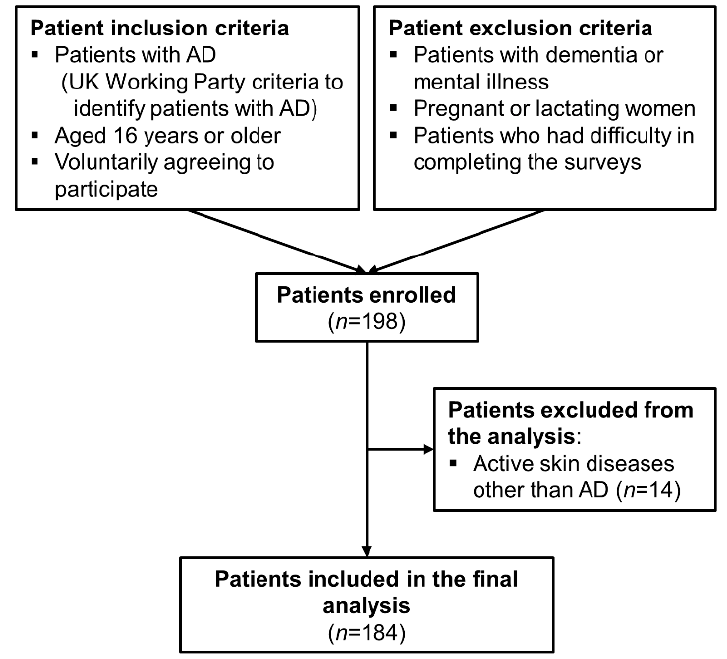
Figure 1. Overview of the patient enrollment process. Table 1. Demographic and clinical characteristics of the patients with AD ( n = 184).